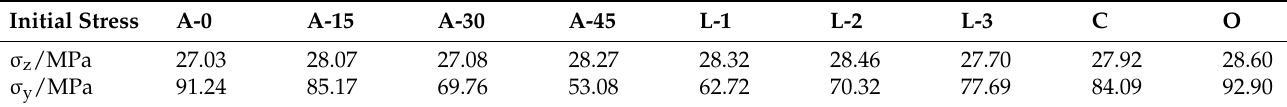
Table 4. Mechanical parameters of different types of rock samples.